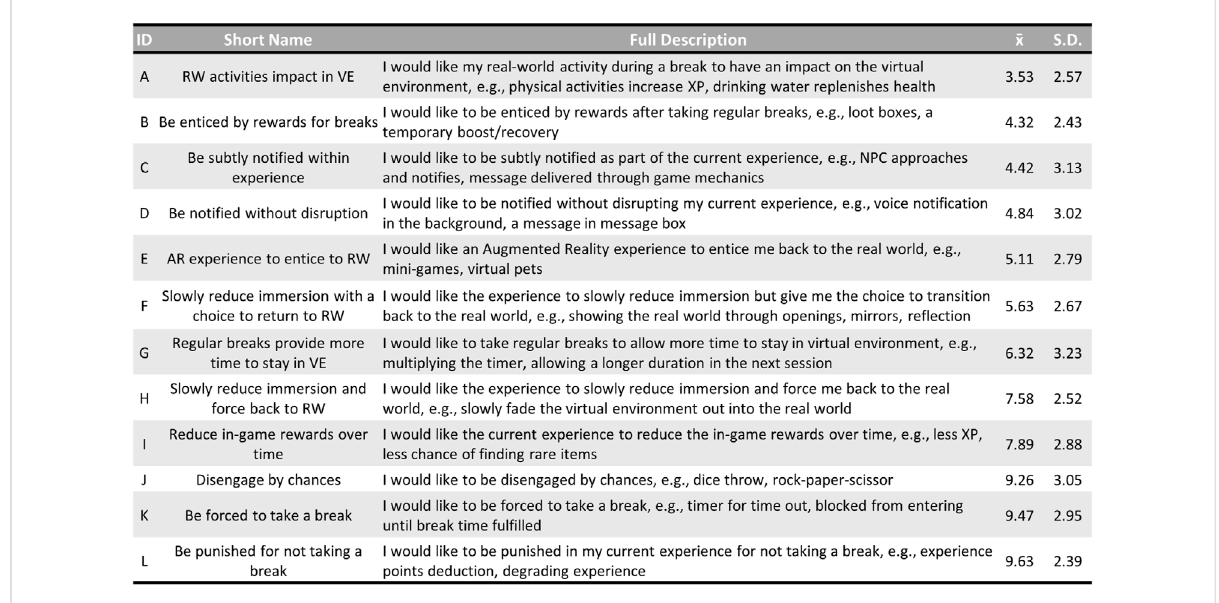
FIGURE 10 The information of twelve general disengagement techniques including their IDs, short names, long descriptions, average ranks, and standard deviations of